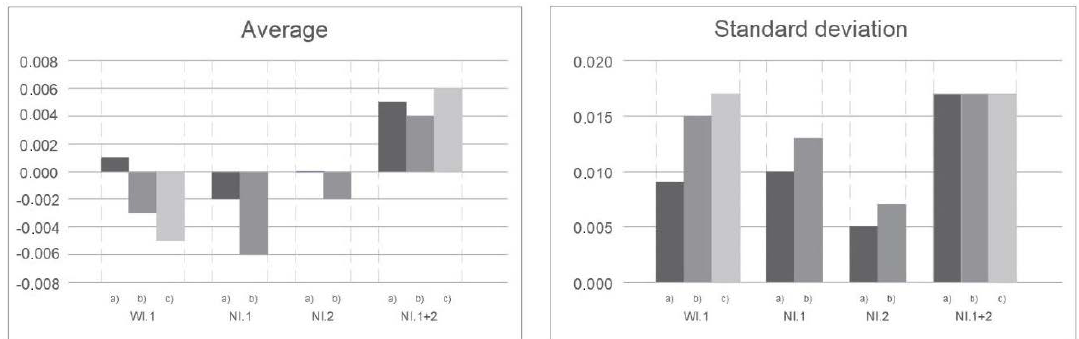
Figure 7. Statistical analysis of distances between reference planes and the walls point cloud. Units in meters.